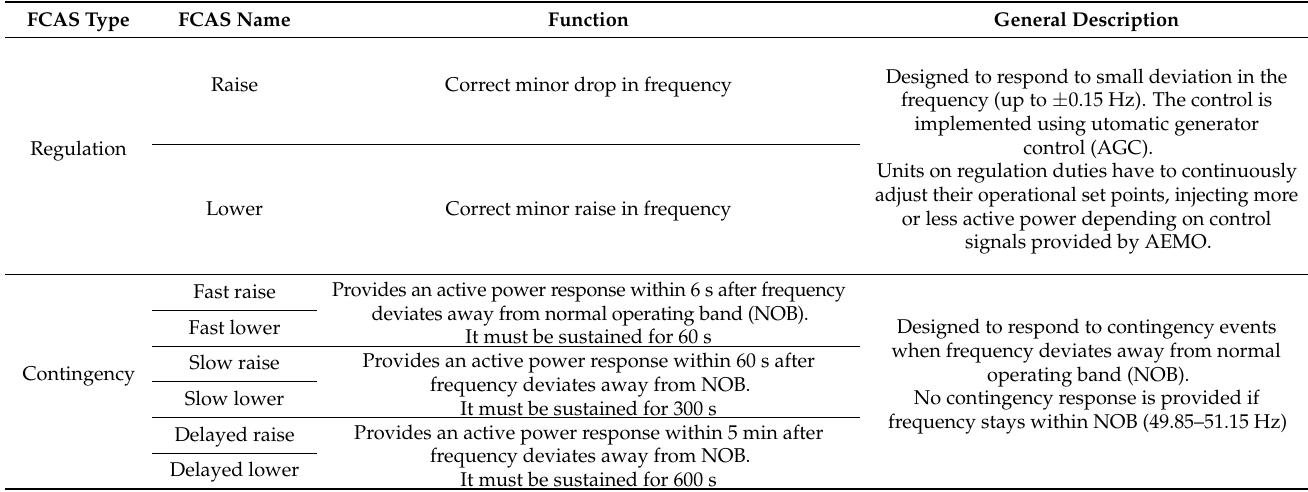
Table 2. FCAS markets in the Australian NEM.